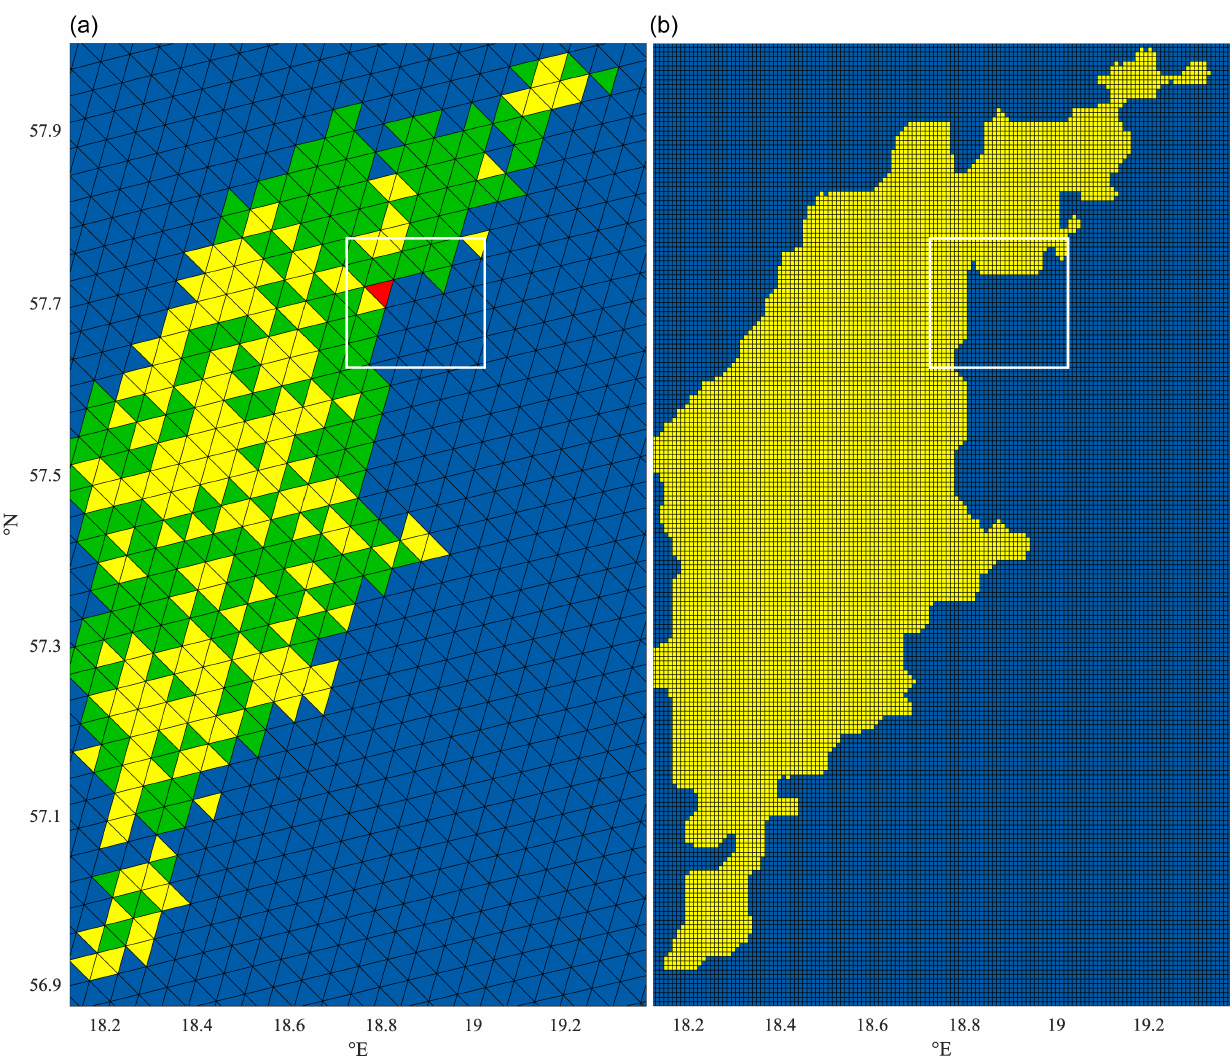
Figure 3. Triangular grid with an effective resolution of 2 . 47km used in ICON (a) and rectangular grid with a resolution of approximately 600m used in GETM (b) over the island of Gotland in the central Baltic Sea; see Fig. 2. In the ICON grid, the different colouring represents cells that consist of more than 50% of ocean (blue), forest (green), urban areas (red) or non-specific land classifications (yellow). GETM only distinguishes between ocean (blue) and land (yellow). The white rectangles frame the area shown in Fig.